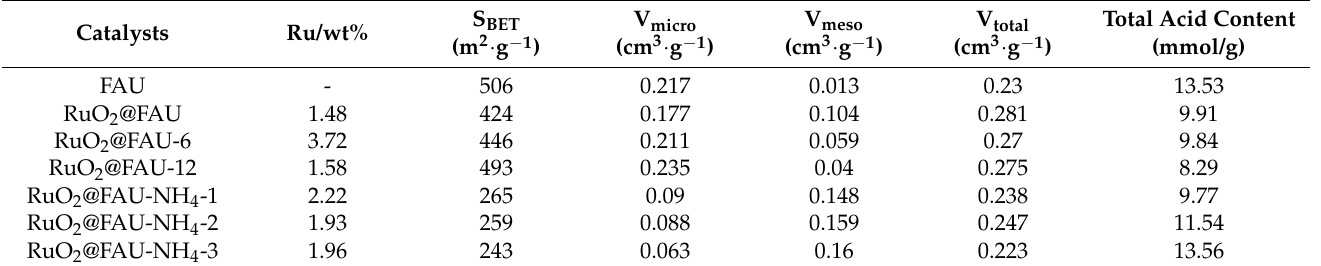
Table 1. The textural and acidic properties of different RuO 2 @FAU